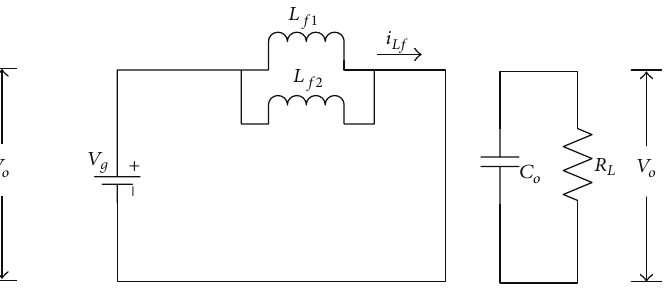
Figure 8: When 𝑆 1 = 𝑆 2 = 0 and 𝑆 3 = 1 .